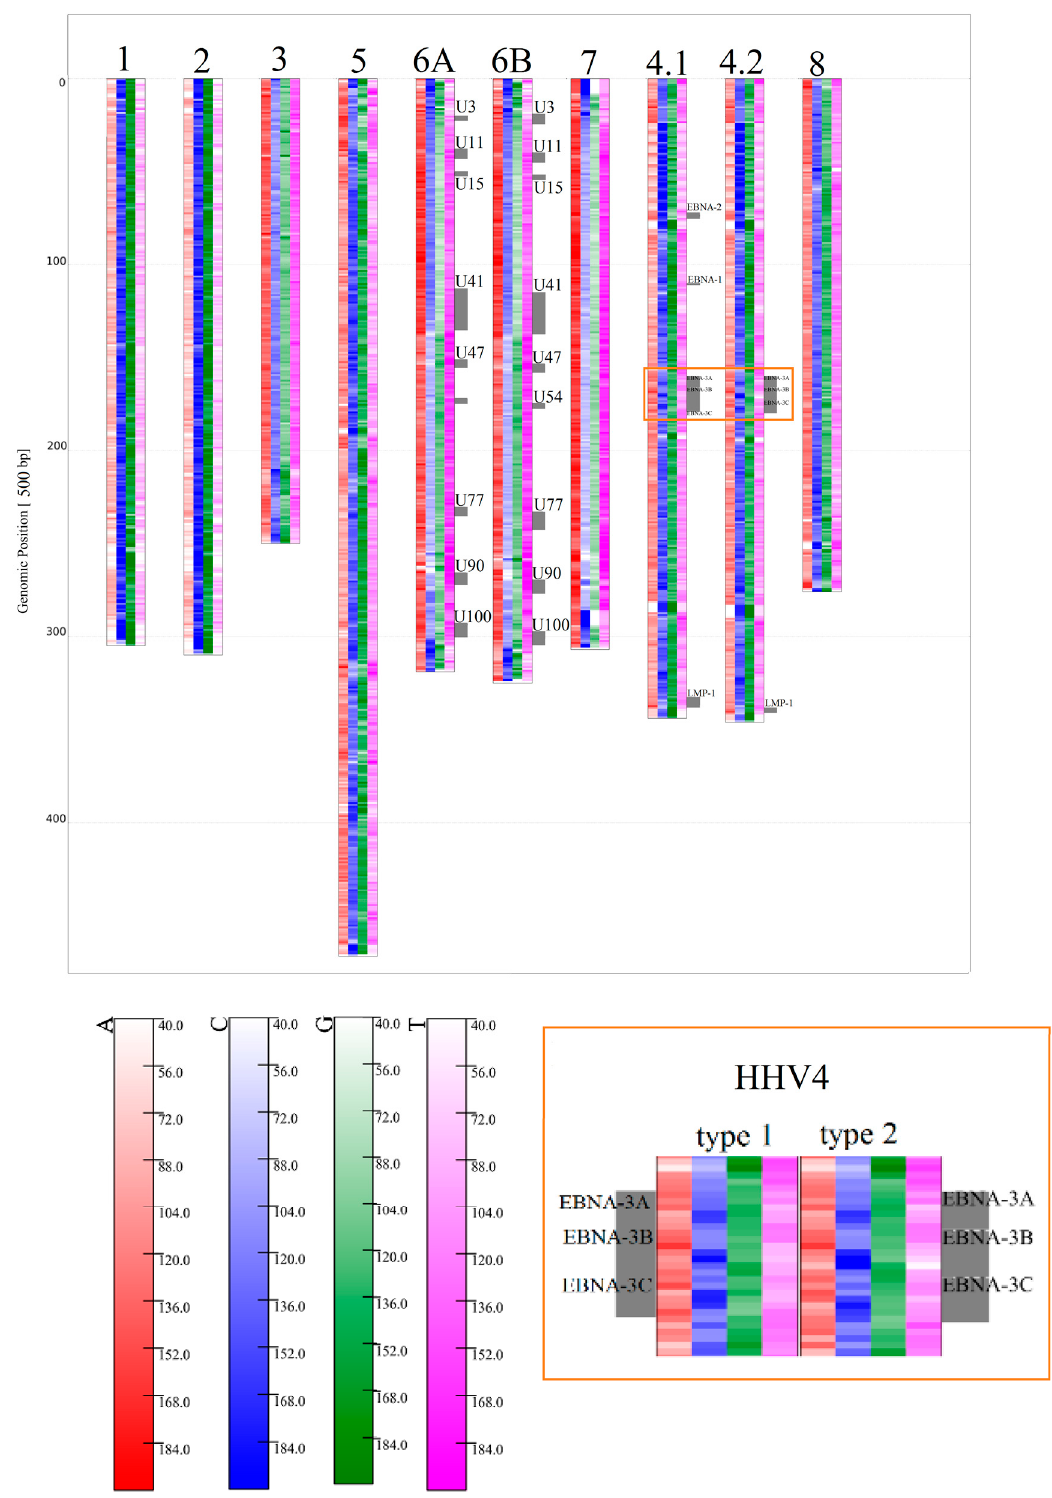
Figure 6. Map of Human Herpesvirus (HHV) genomes for k = 1, with a bin width of 500 bp. From left to right: HHV1, 2, 3, 5, 6A, 6B, 7, 4 type 1, 4 type 2, 8. Genes associated with low conserved regions on HHV6A, 6B, 4 type 1, and 4 type 2 were visualized with gray bars at the side of the genomes. At the right bottom corner, a small region around the EBNA genes for both HHV4 species is shown to illustrate small differences in the local k -mer structure.